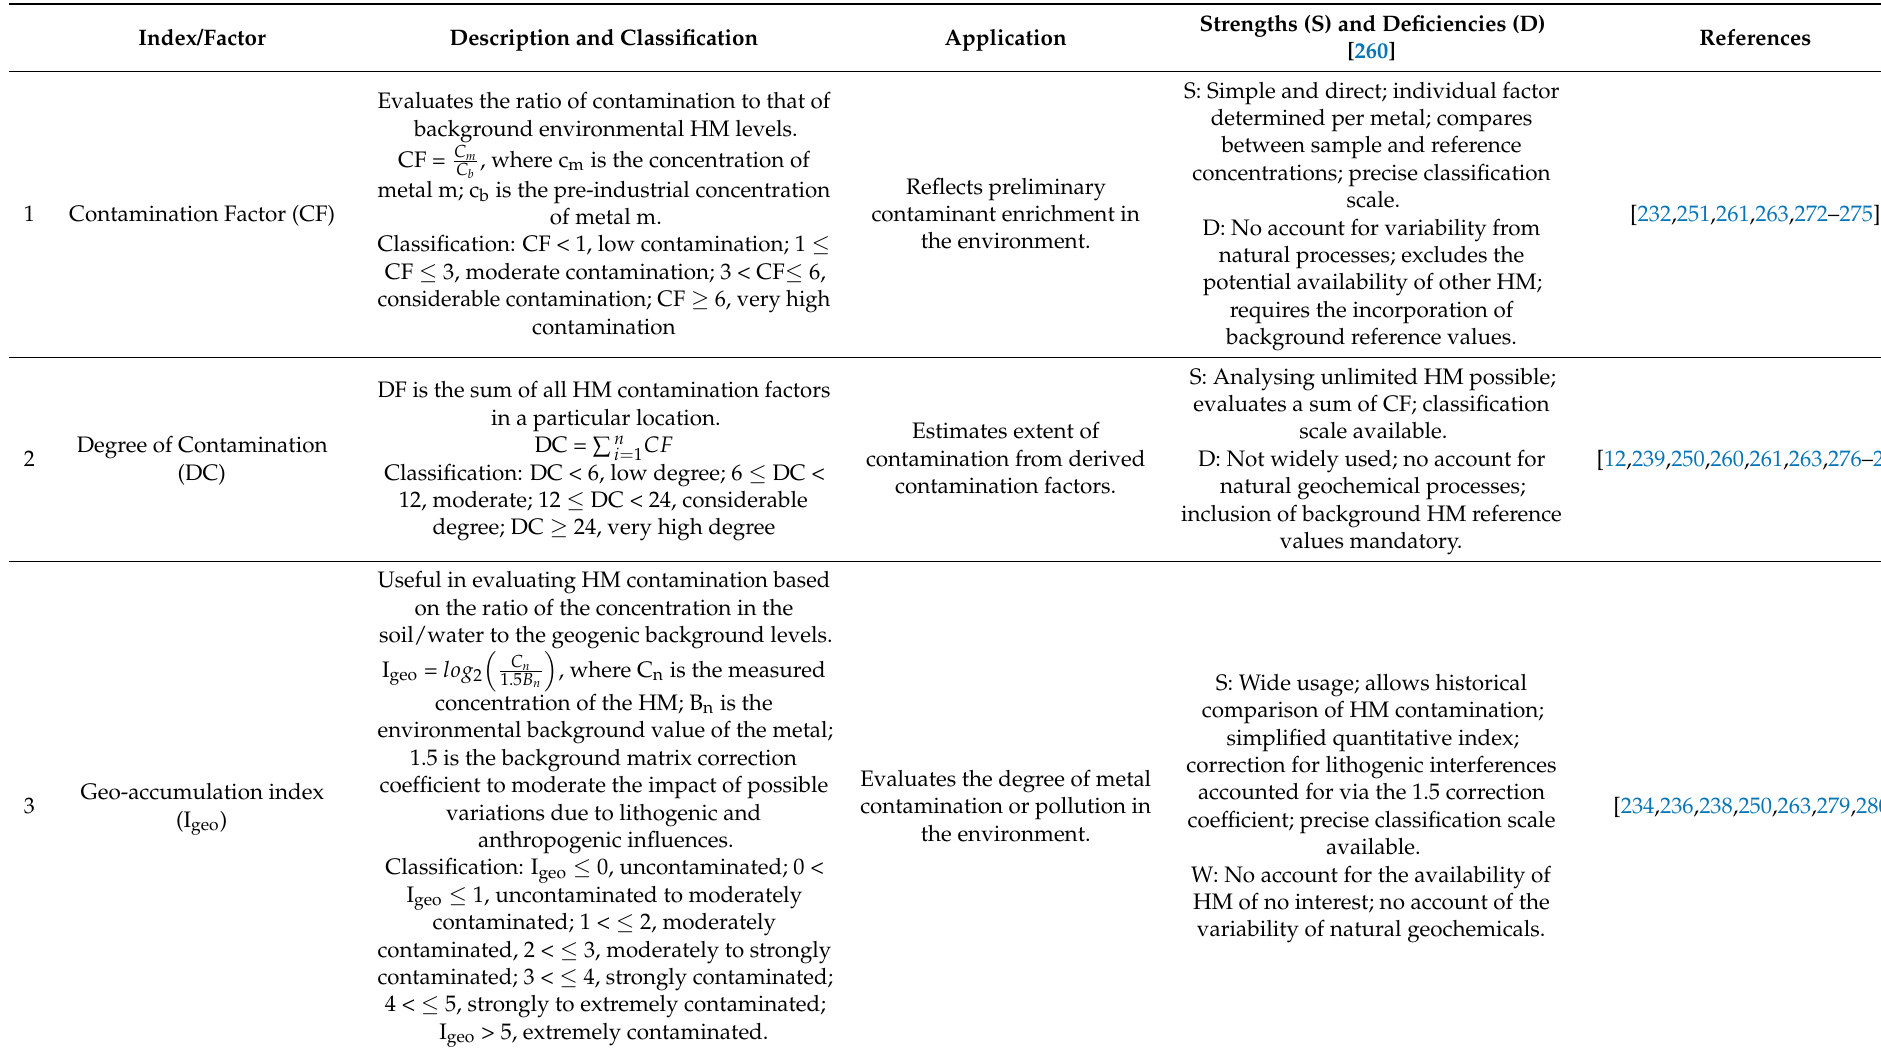
Table 2. Characteristics and applications of environmental pollution factors and indices in the ERA of heavy-metal